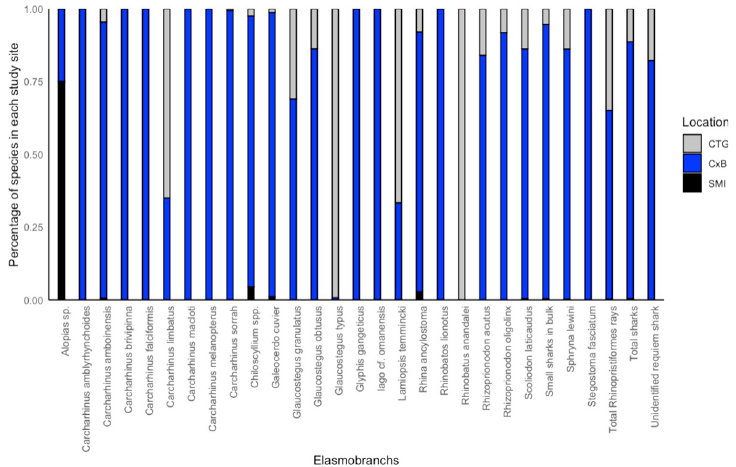
elasmobranchs (Fig 8C). ANOVA models resulted in positive relationships with gears and increasing total length (p < 0.001, F-statistic: 99.34 on 5 and 1158 DF, Intercept 63.3, etasq 0.300, partial.etasq 0.300, omegasq 0.297, partial.omegasq 0.297, cohens.f 0.655, power 1: 100% chance of finding a statistically significant difference). The model effect size is moderately large. The positive relationship was found for generally gillnets (p < 0.03) both for floating gill- nets (p < 0.001), large mesh gillnets (p < 0.0001), hooks (p < 0.0001). For seine nets (p < 0.0001)